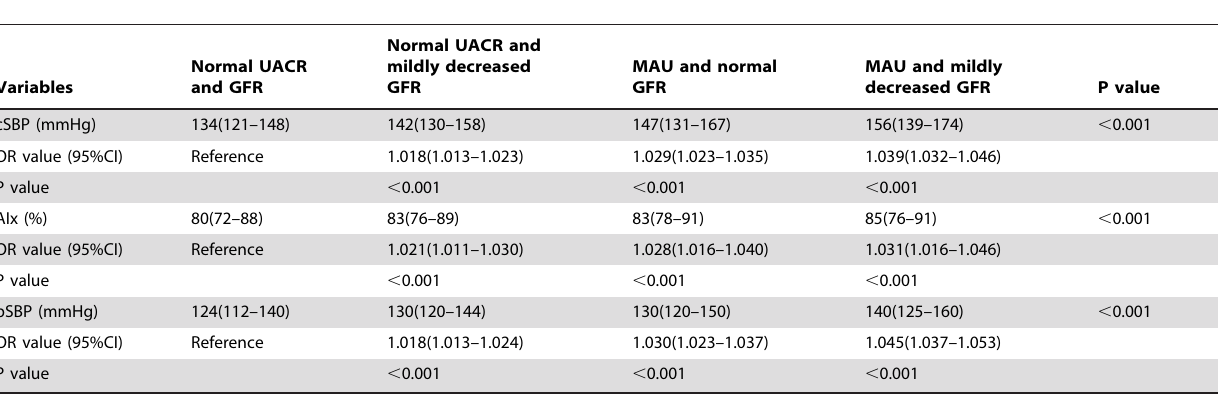
Table 2. Description of AIx and BP in subgroups based on the presence or absence of MAU and mildly decreased GFR.